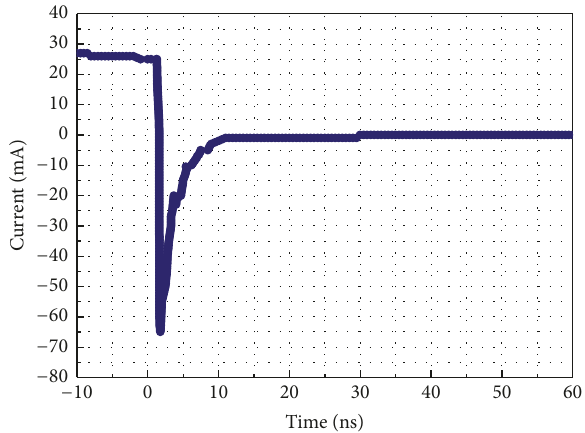
Figure9:Oscillogramofthecurrentof4 H -SiC ⟨ Al ⟩ diodemeasured at switching from the forward current ( 𝐼 = 25 mA) to a reverse voltage of